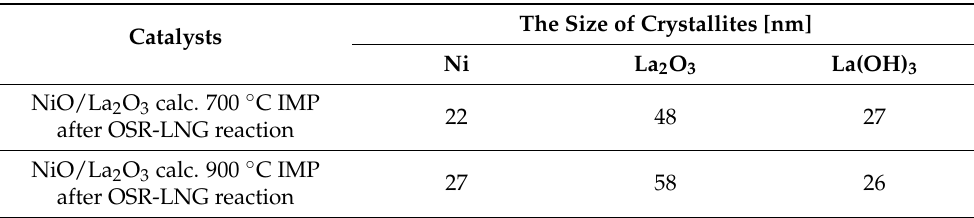
Table 7. The size of the crystallites calculated from the XRD measurements of spent NiO/La 2 O 3 IMP catalysts in the OSR of LNG